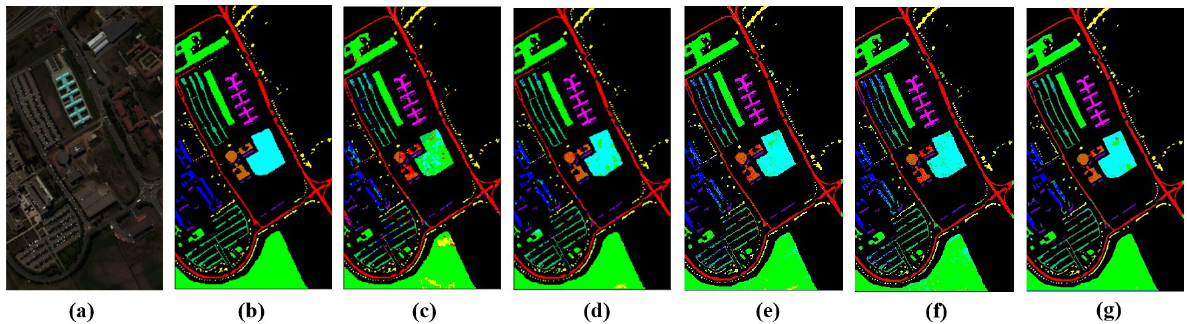
Figure 9. Classification maps of different models for Pavia University dataset: ( a ) false color com- posite image; ( b ) ground truth; ( c ) SS3FCN; ( d ) TAP-Net; ( e ) DA-IMRN (sub-net1); ( f ) DA-IMRN (sub-net2); ( g )